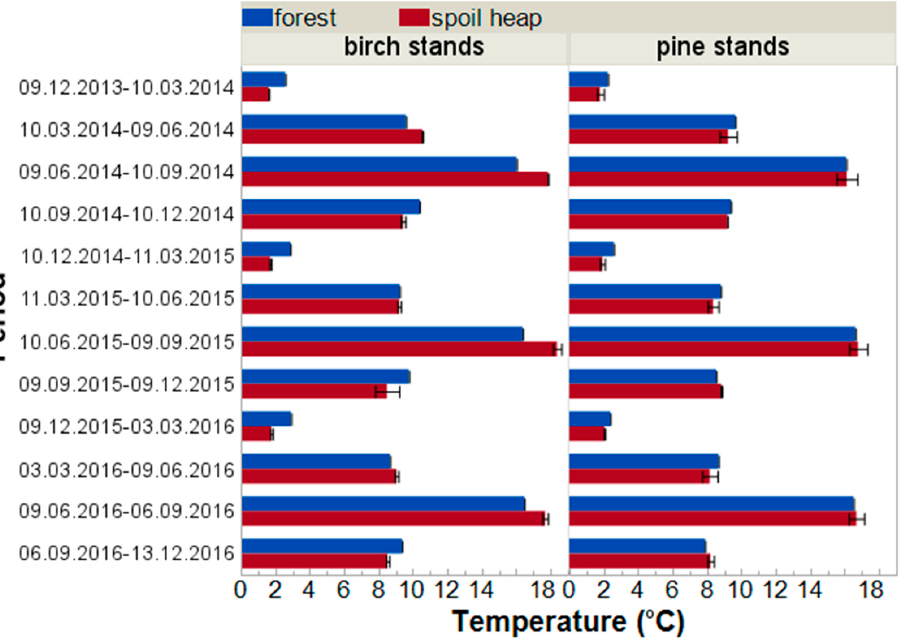
Figure A1. The average temperatures ( ◦ C, ± SE) of upper soil layers in birch and pine stands growing on two di ff erent site types—post-mining external spoil heap (red) or forest sites (blue). Measurement periods were appropriate to decomposition time intervals.